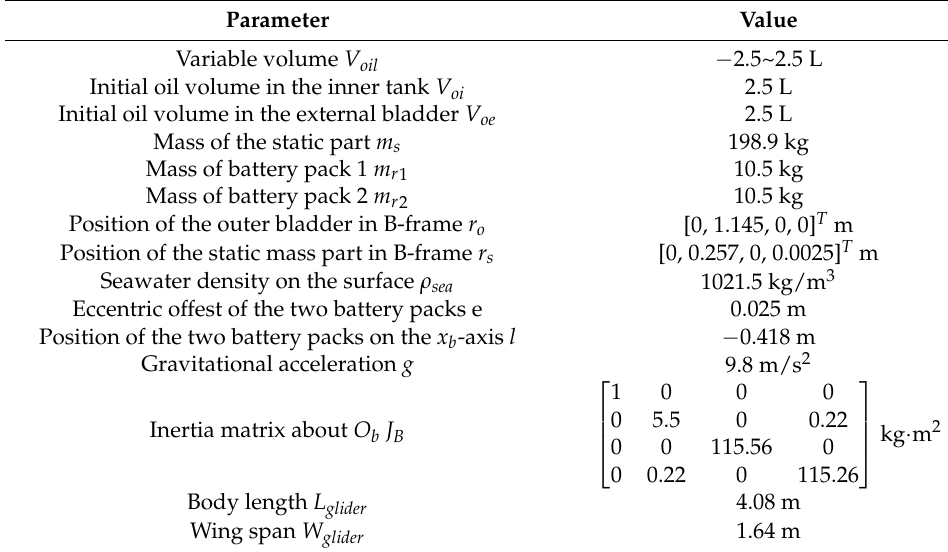
Table A2. The main parameters of Petrel-X